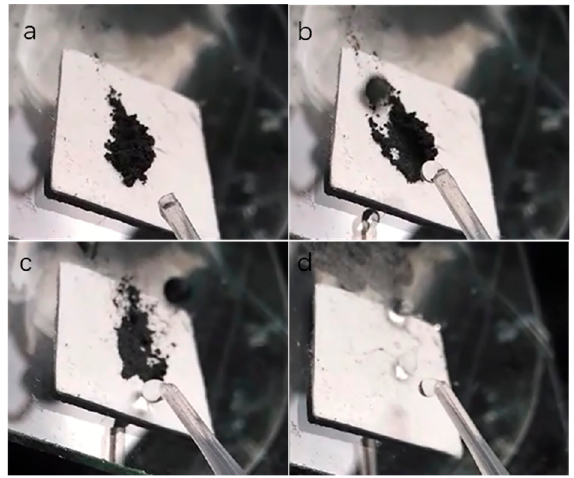
Figure 6. Sequential snapshots of self-cleaning performance of the as-prepared superhydrophobic paper ( a – d ).